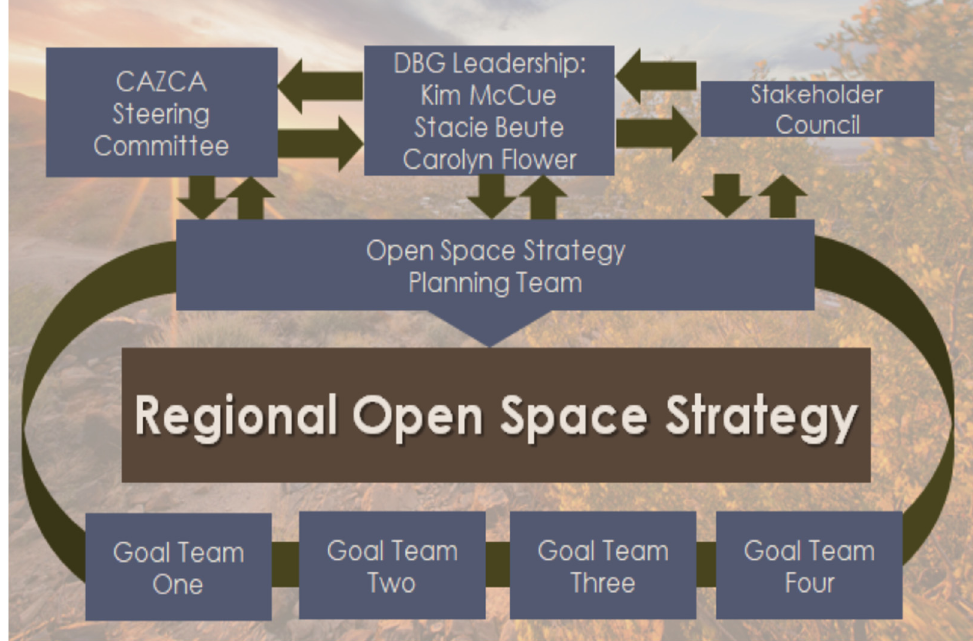
Figure 5. Phase two of the structure that CAZCA utilized in planning the ROSS.